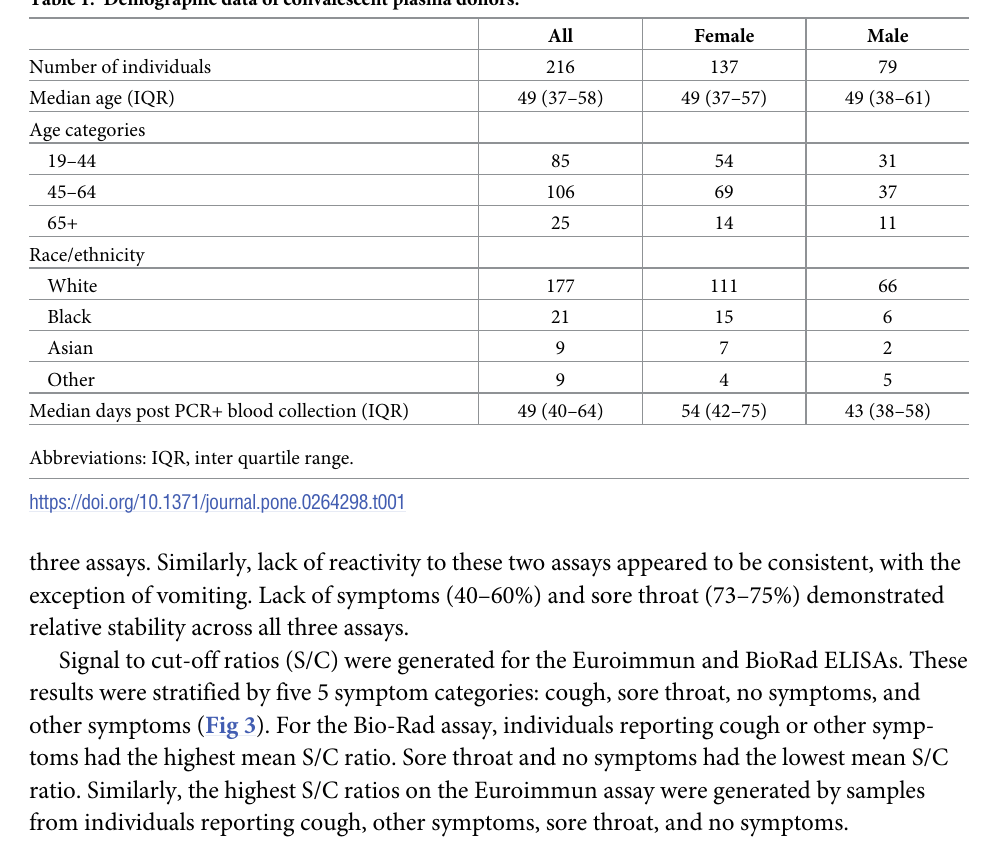
Table 1. Demographic data of convalescent plasma donors.